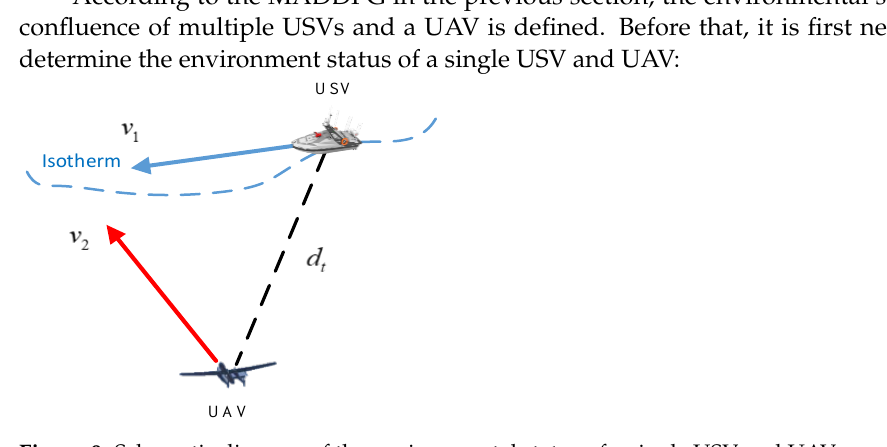
Figure 9. Schematic diagram of the environmental status of a single USV and